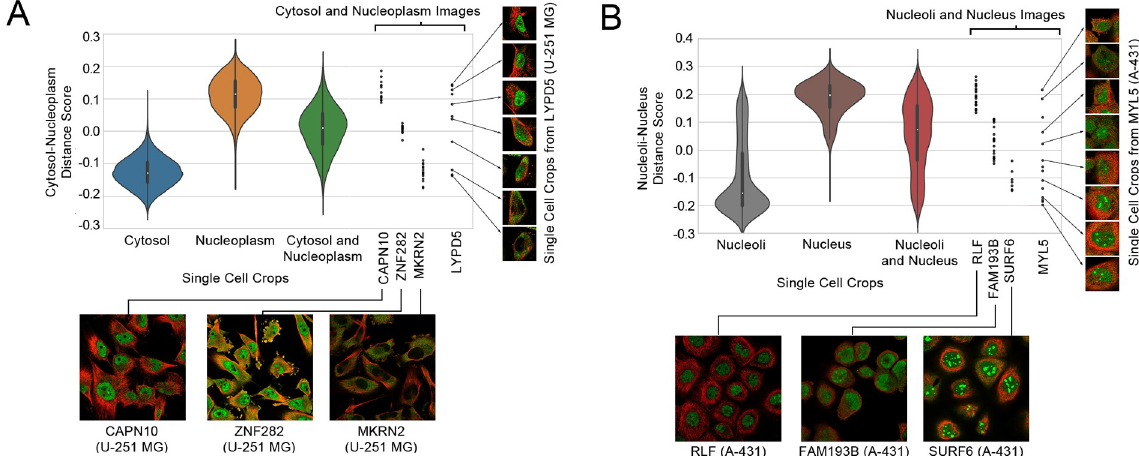
Fig 5. Single-cell scores (as explained in the text) for cytosolic-and-nucleoplasm cells (A), and nucleoli-and-nucleus cells (B). We visualize single cells as violin plots. The black boxes inside the violin plots show the interquartile ranges and the white dots show the medians. To the right of the violin plots, we show all of the single-cells for four different images of proteins annotated to be multi-localizing to either the cytosol- or-nucleoplasm or the nucleolus-and-nucleus as black dots, as labeled in the x-axis. For each image, we show either a representative crop of the image, or multiple single cell crops; in both cases, the protein is shown in green, while the microtubule is shown as red. Note that while the violin plots include all cell-lines, we show four examples from the same cell-line for each plot (the U-251 MG cell line for cytosol-nucleoplasm and the A-431 cell line for nucleoli-nucleus), to demonstrate that images from the same cell-line can have different scores depending on their phenotype.